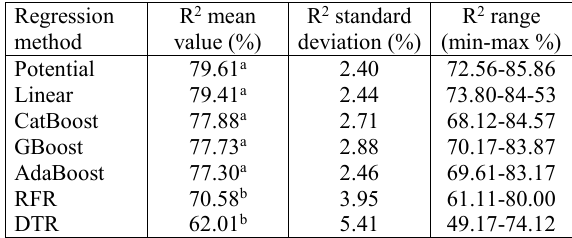
Table 1 . Statistics of R 2 for bivariate allometric models DBH = Ψ(H). Mean values with different superscript letters are significantly different (p<0.05) (two-sample t-test).